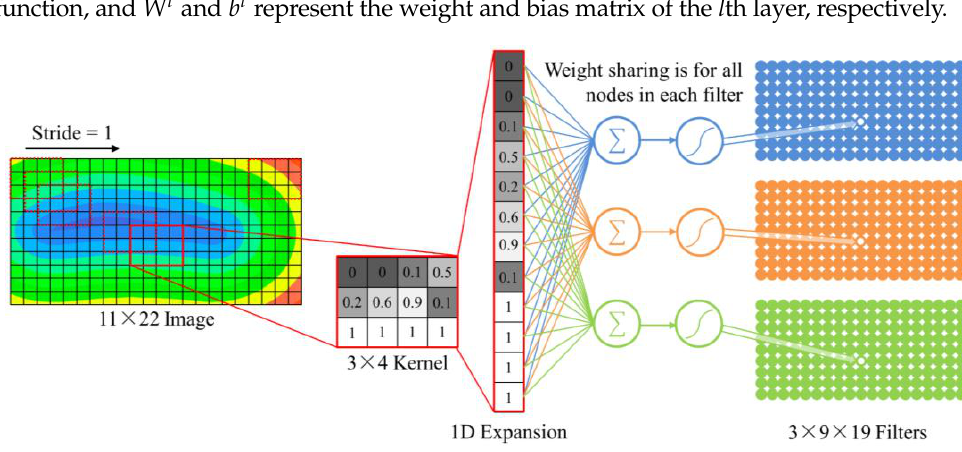
Figure 3. The schematic of a convolutional layer (numbers are for illustration purposes only; bule, orange, and green represent different filters).